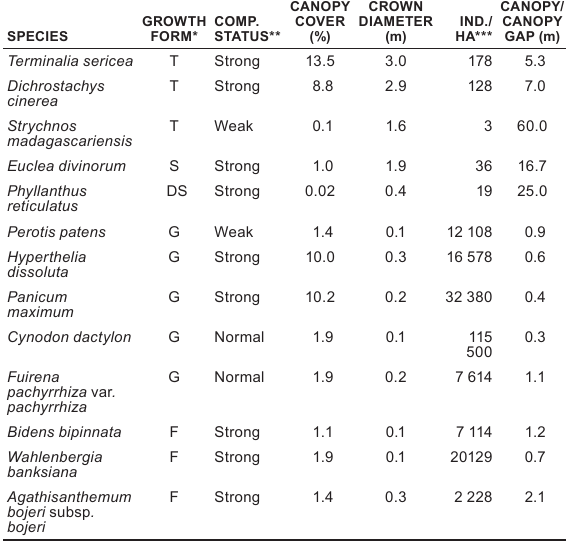
table 4 Species and growth form relations in Community